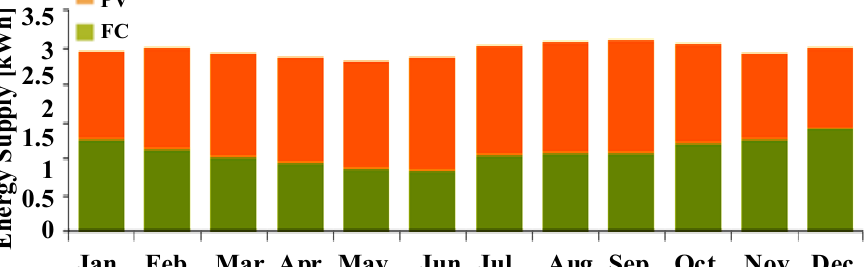
Figure 13. Monthly electric loads power supply by the PV and FC.